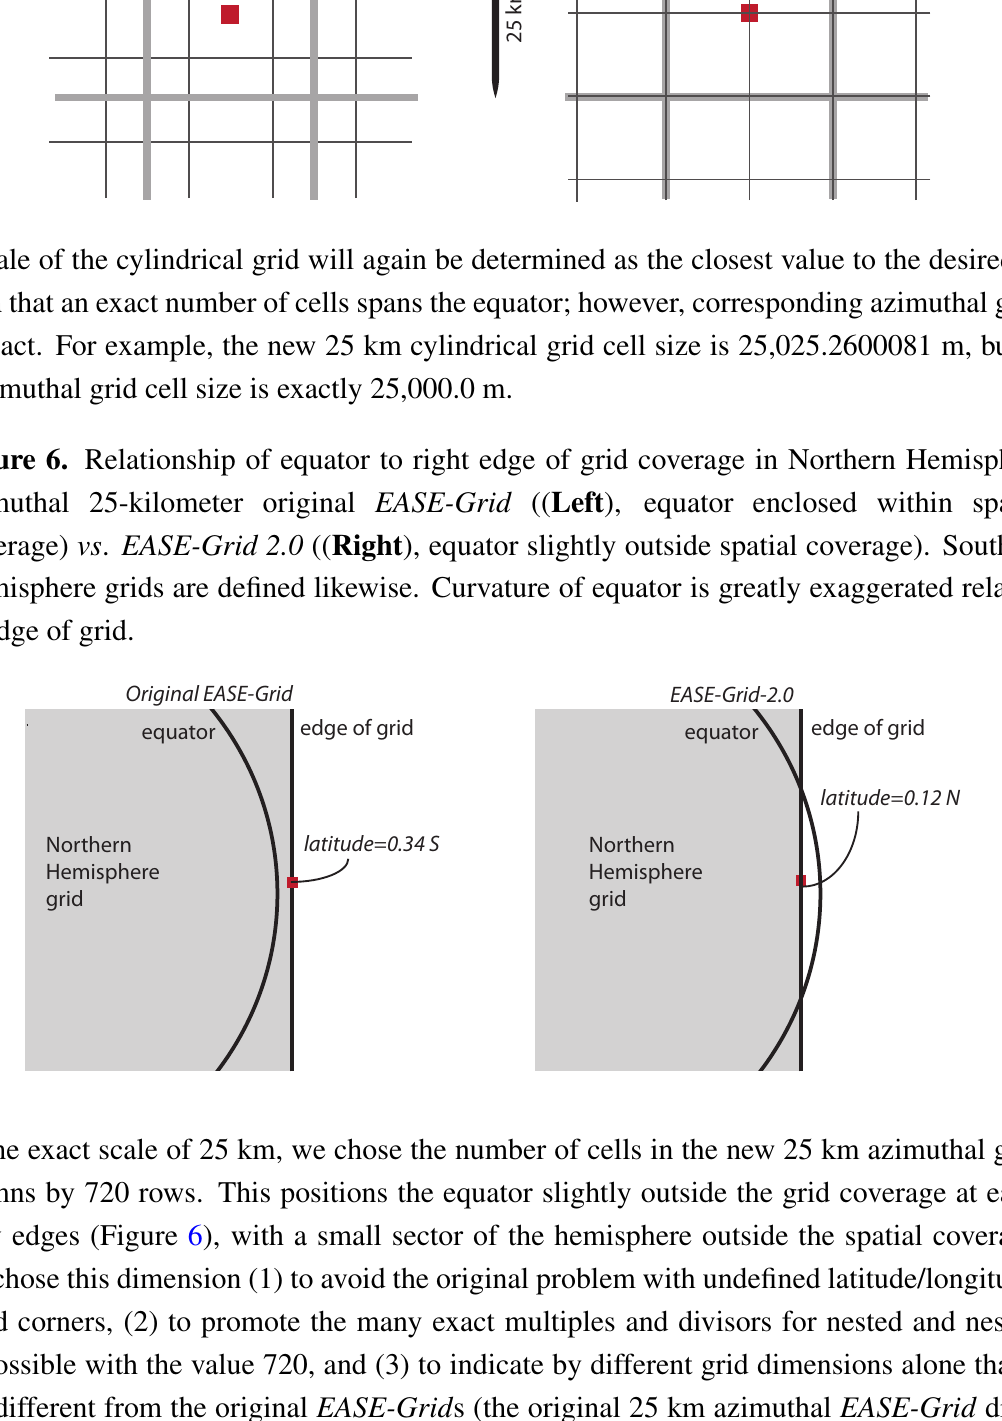
grids are different from the original EASE-Grid s (the original 25 km azimuthal EASE-Grid dimensions are 721 columns × 721